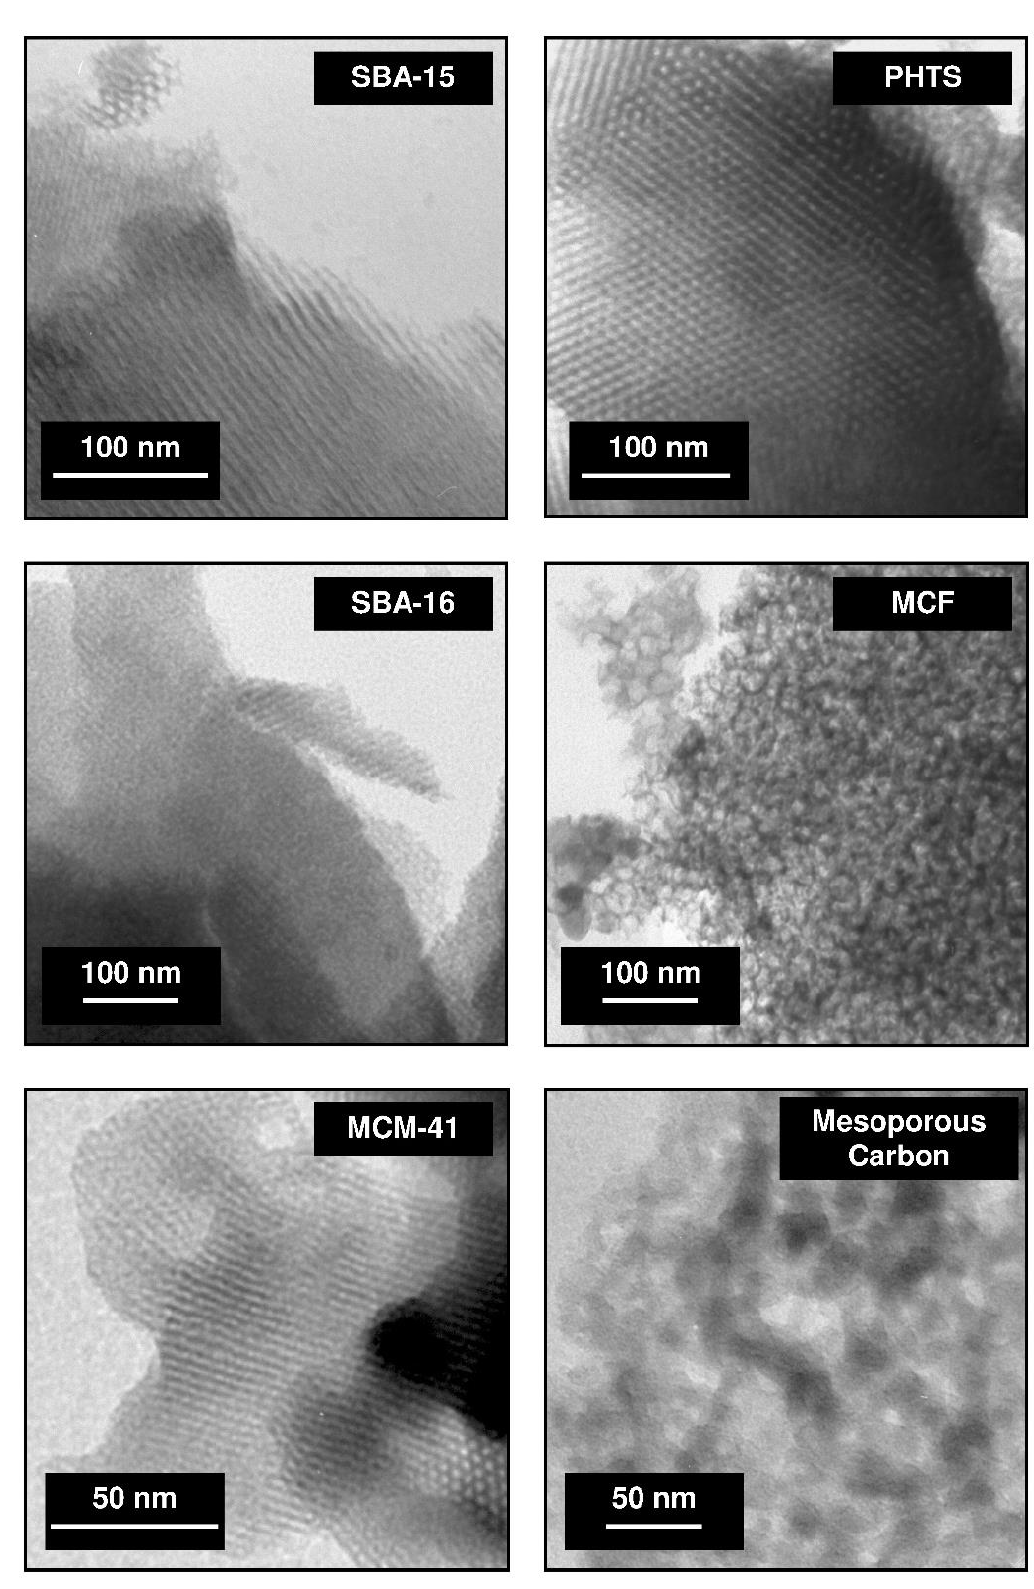
Figure 1. TEM micrographs of various mesoporous materials (abbreviations: SBA-15, Figure 1 . TEM micrographs of various mesoporous materials (abbreviations: SBA-15, 16 – Santa Bar- bara acid; PHTS – plugged hexagonal templated silica; MCF – mesocellular foam; MCM-41 – Mobil Composition of Matter). The micrographs were collected using Jeol JEM 1200 EX electron micro- scope and come from the authors’ own collection.